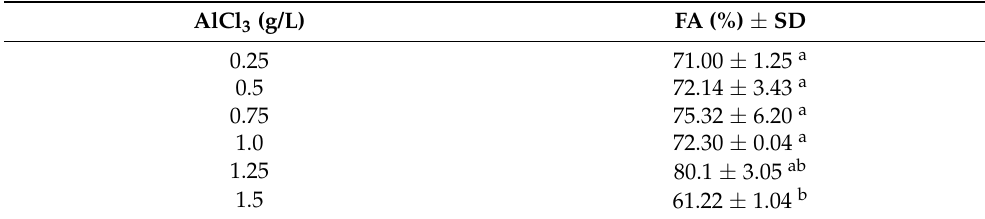
Table 5. Effect of AlCl 3 concentrations on flocculation.